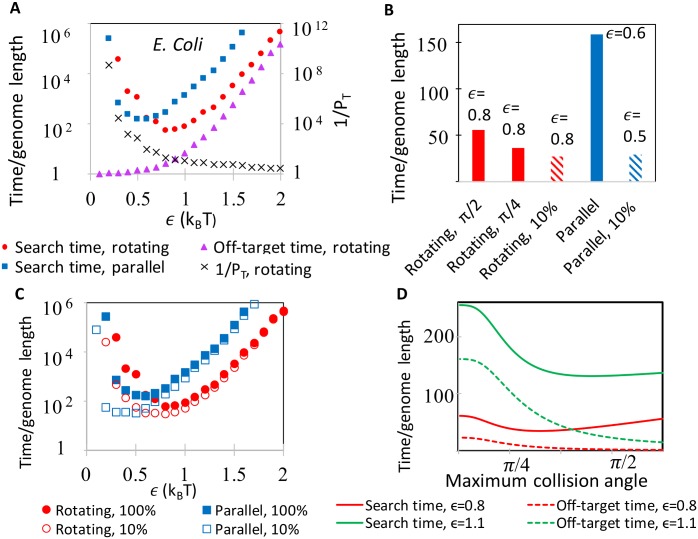
Determinants of total search time.(A) Kinetics of search as a function of ϵ, the attractive energy per matched site. Mean search time for a freely rotating searcher (red) and constrained parallel searcher are compared with the average interaction time with off-target sequence per search cycle for freely-rotating searcher (purple). Also shown is the mean number of pairing attempts, 1/PT. Here τdiff = 0, θmax = π/2, and genome statistics taken from the E. coli genome. All times in this figure are measured in units in which the rate of unbinding equals 1. (B) Minimum attainable homology search times. Indicated are the θmax (π/2 when not indicated), the required specificity (100% if not indicated), and the value of ϵ at which these minima occur. (C) Comparison between the search time with TD set to guarantee perfect specificity(σ = 1, as in panel B), and when it is set such that σ = 0.1 (empty symbols). (D) Homology search time (solid lines) and average off-target interaction time (dashed lines) for a freely rotating searcher as a function of θmax.